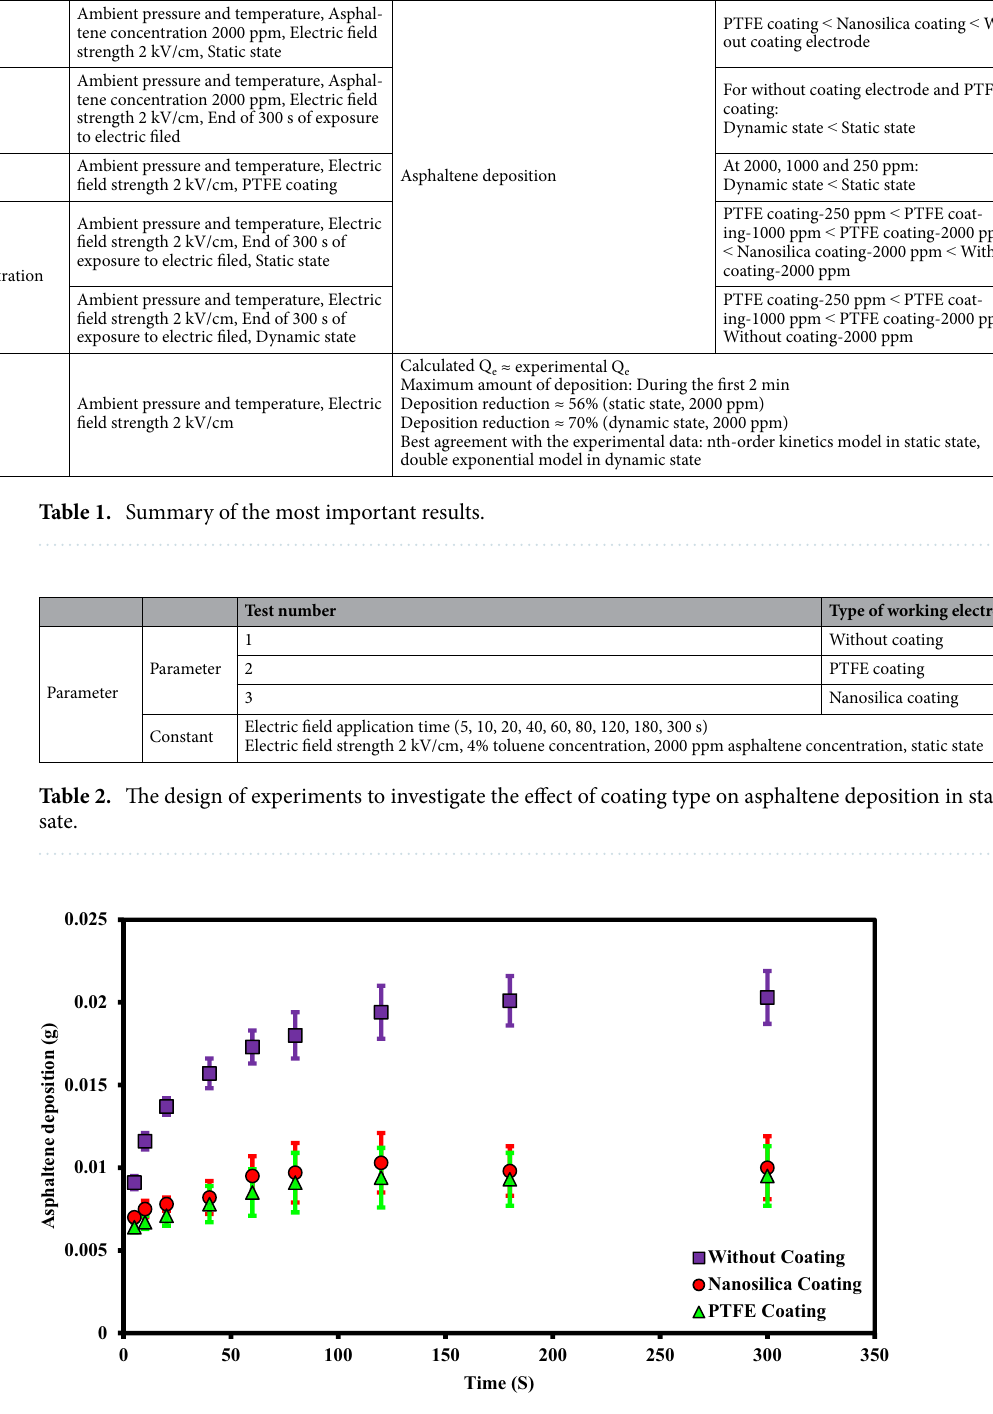
Figure 4. Asphaltene deposition rate on uncoated and coated electrodes for different exposure times to electric field at ambient pressure and temperature (Asphaltene concentration 2000 ppm, Electric field strength 2 kV/